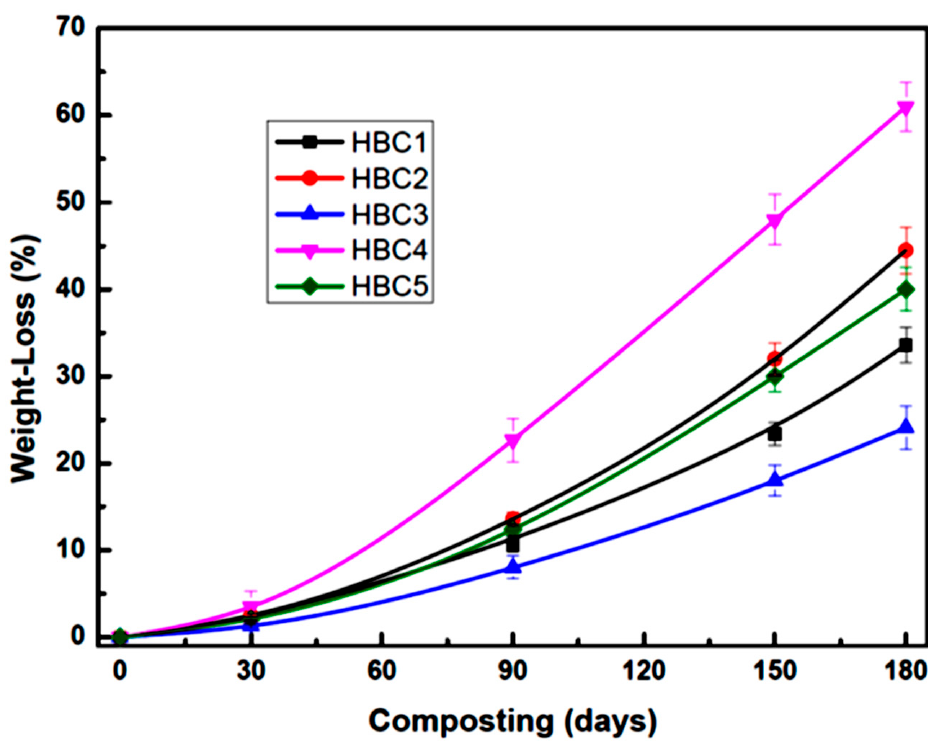
Figure 4. HBCs weight loss changes during composting.